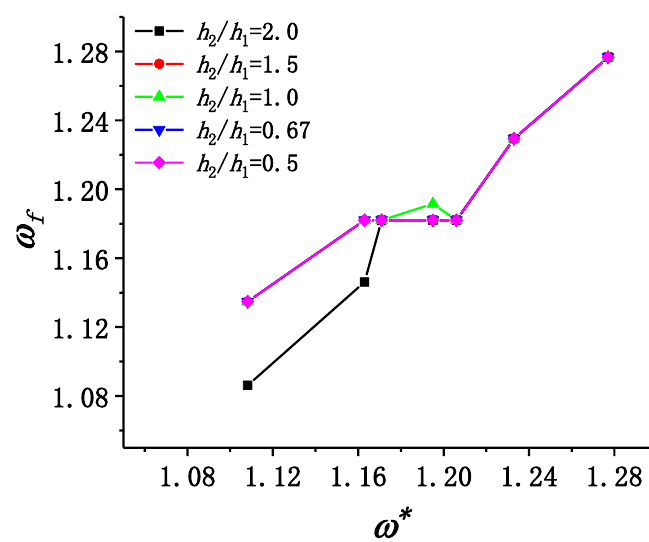
Figure 9. Variation in the frequency of fluid oscillation in the narrow gap with angular frequency of incident wave.